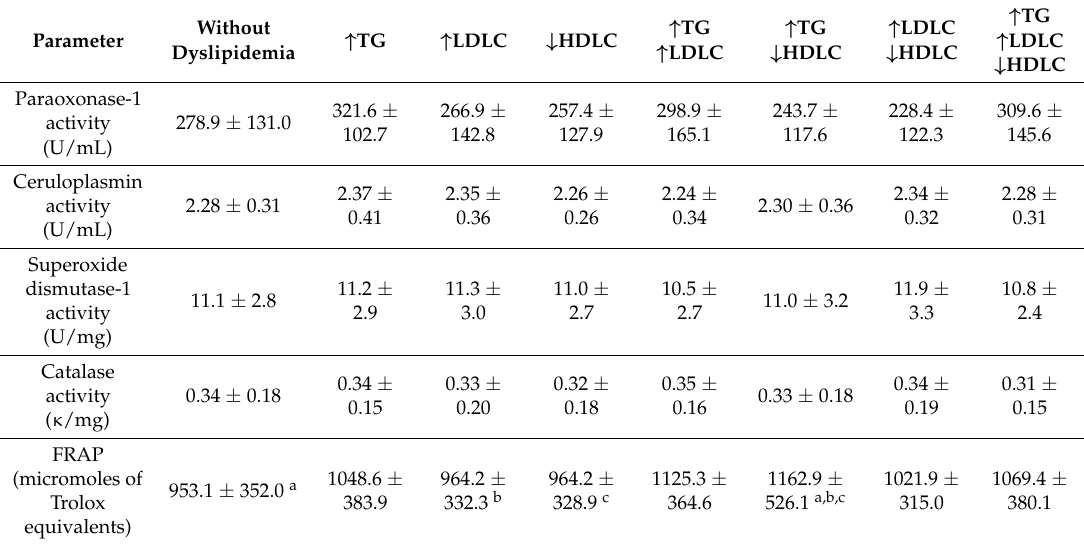
Table 2. Descriptive data of the antioxidant enzymes activity and the ferric-reducing ability of plasma